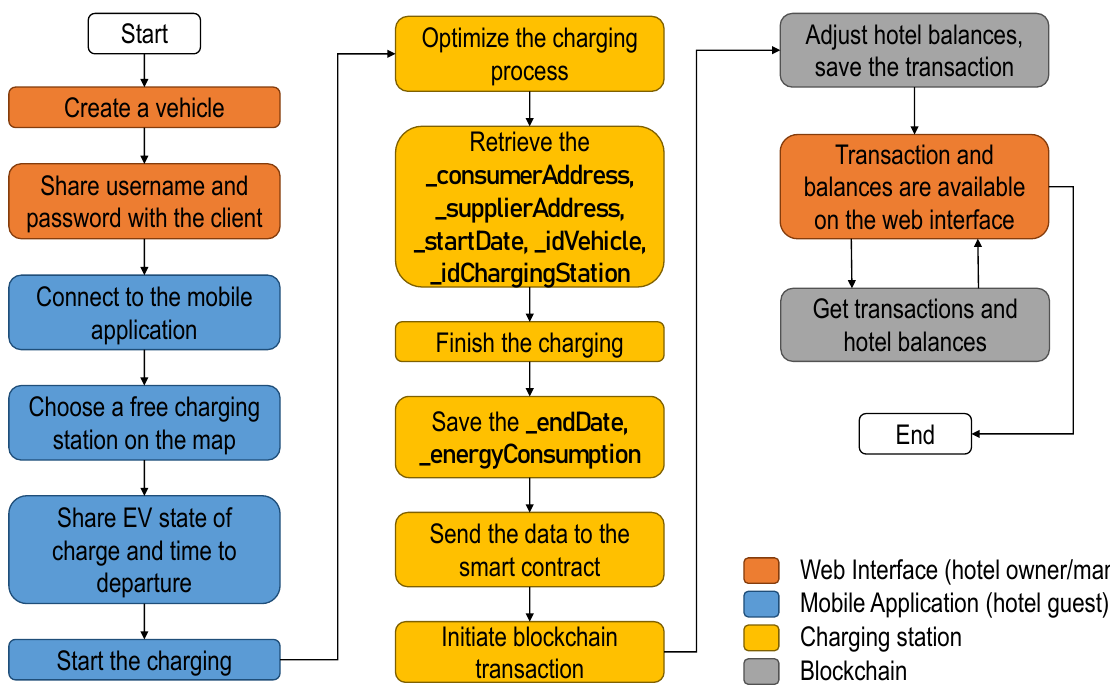
Figure 5. EV charging process